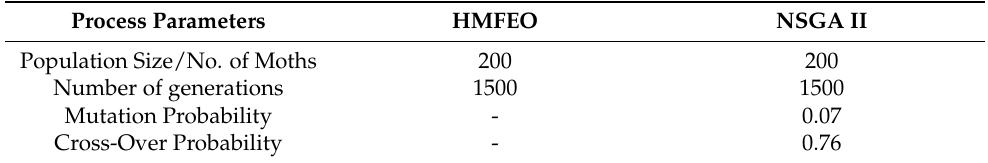
Table 5. Initialization of parameters for proposed solution algorithm.